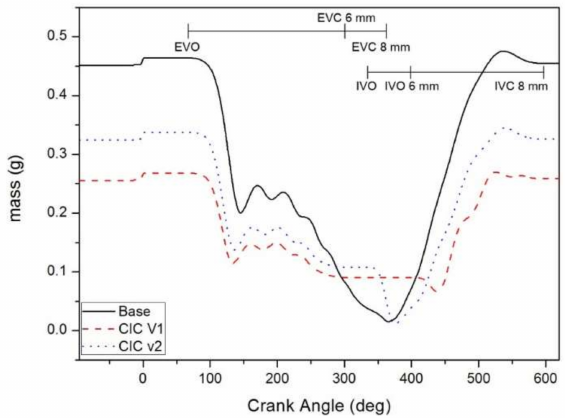
Figure 6. Total trapped mass traces for three different recompression